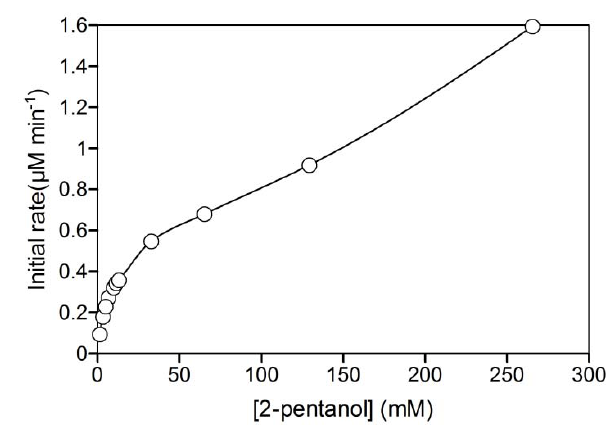
Figure 6. Relationship between the initial reaction rate of A . pernix ADH and the concentration of 2-pentanol in 50 mM potassium phosphate buffer, pH 7.4,